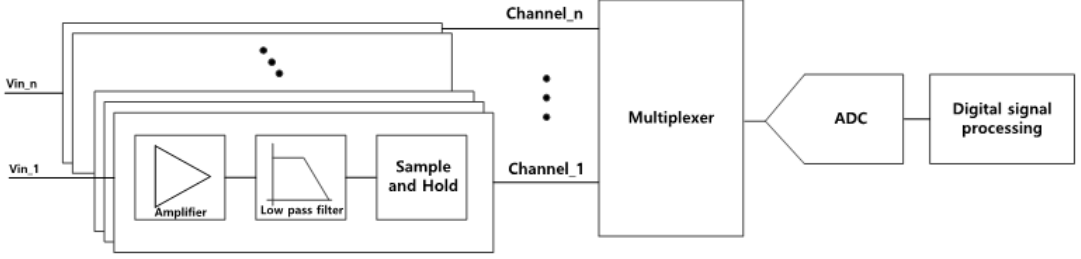
Figure 1. Conventional block diagram of the analog front end (AFE) [6].